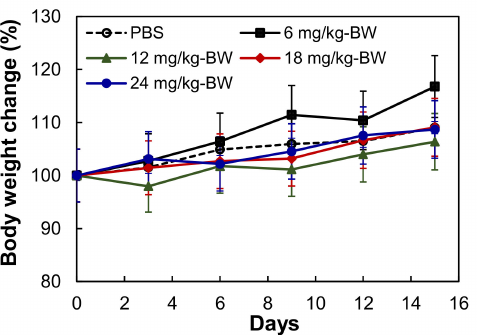
Figure 4. Dosage effect of mAb-Lipo-drugs on body weight of mice. PBS ( ( (cid:78) ), 18 mg/kg ( (cid:7) ), and 24 mg/kg ( • ). n = 3.